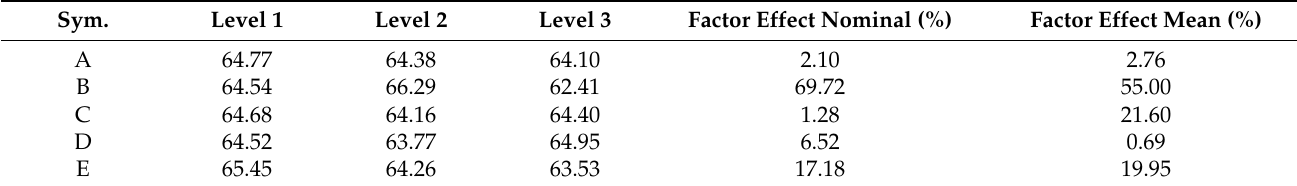
Table 3. S/N ratios of process parameters and factor effects for a PMOS device.